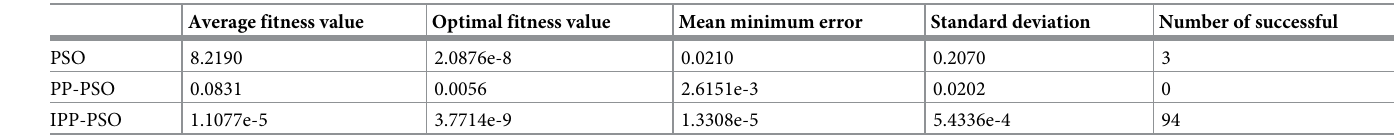
Table 4. Simulation results of two-person non-zero-sum